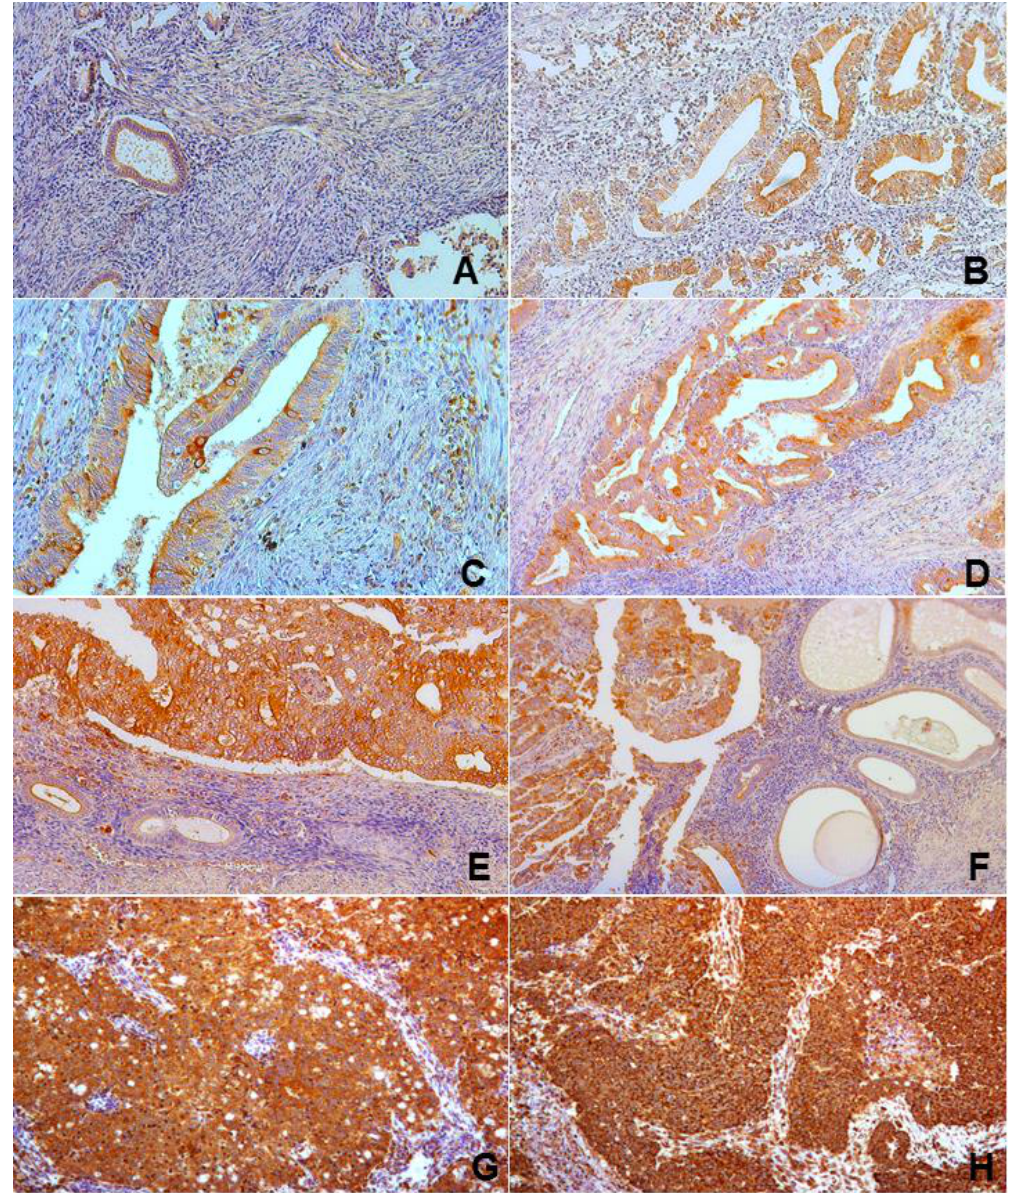
Figure 1. Representative patterns of RANK immunohistochemical staining ( brown color) in normal ( A ), hyperplastic ( B ), and malignant ( C – H ) endometrium. Illustrative examples of the histological grade I ( C , D ), II ( E , F ), and III ( G , H ) tumor tissues are shown. Intense staining in epithelium of all samples with widely increased signal in undifferentiated areas of malignant tissues ( C – H ) was observed. Signal augmented gradually with the increasing histological grade. Note clear cytoplasmic as well as nuclear staining in epithelial and stroma cells of malignant tissue ( C ). A typical honeycomb staining pattern for RANK was observed in malignant tissue of different histological grade tumors ( D , E ). Note increased signaling in RANK staining in the upper (malignant) vs. lower (normal) areas of the tissue in ( E ). Also, note wider distribution of RANK signaling in histological grade III tumors ( G,H ) vs. lower grade ( C – F ) and normal ( A ) endometrium. Magnifications, ×100 ( A , B , D – H ) and ×200 ( C ).